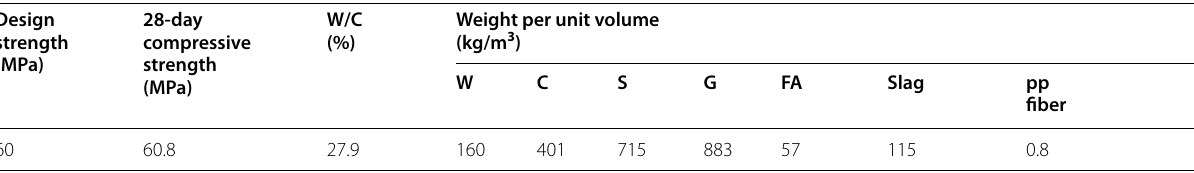
Table 2 Mixture ratios for